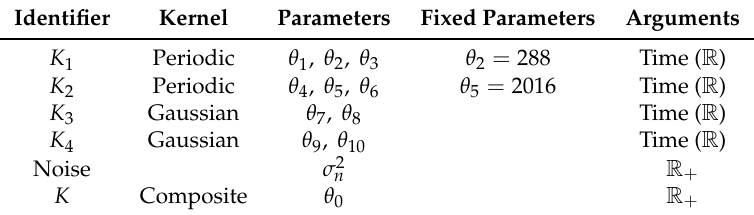
Table 2. The parameters of the composite kernel described by Equation (9).